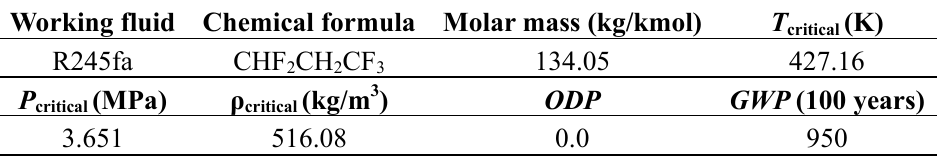
Table 3. Main properties of the working fluid